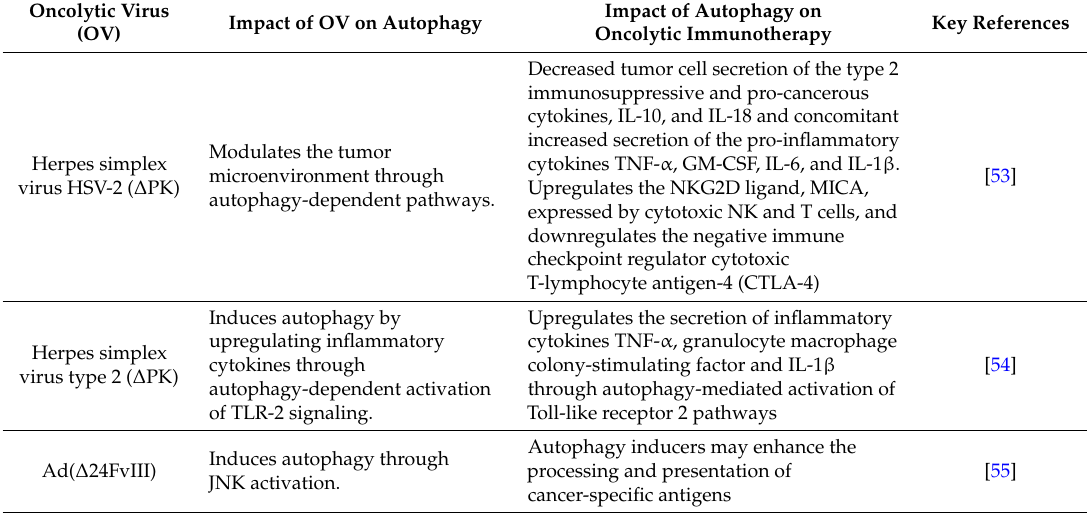
Table 1. Summary of Oncolytic Virus (OV)-modulated autophagy in oncolytic immunotherapy. Oncolytic Virus